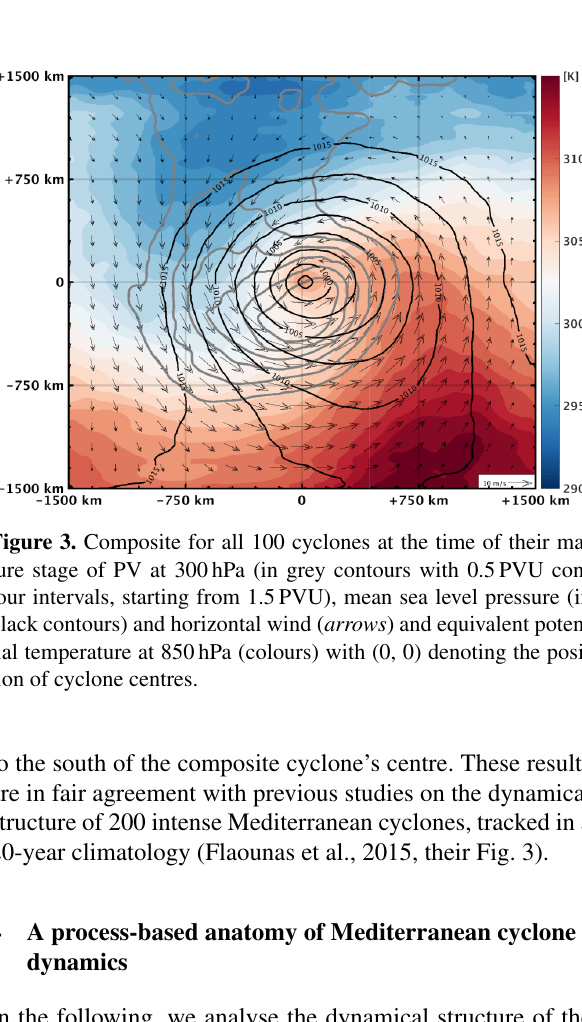
Figure 2. (a) Monthly distribution of cyclone occurrence. (b) Cyclones sorted according to their central mean sea level pressure during their mature stage.